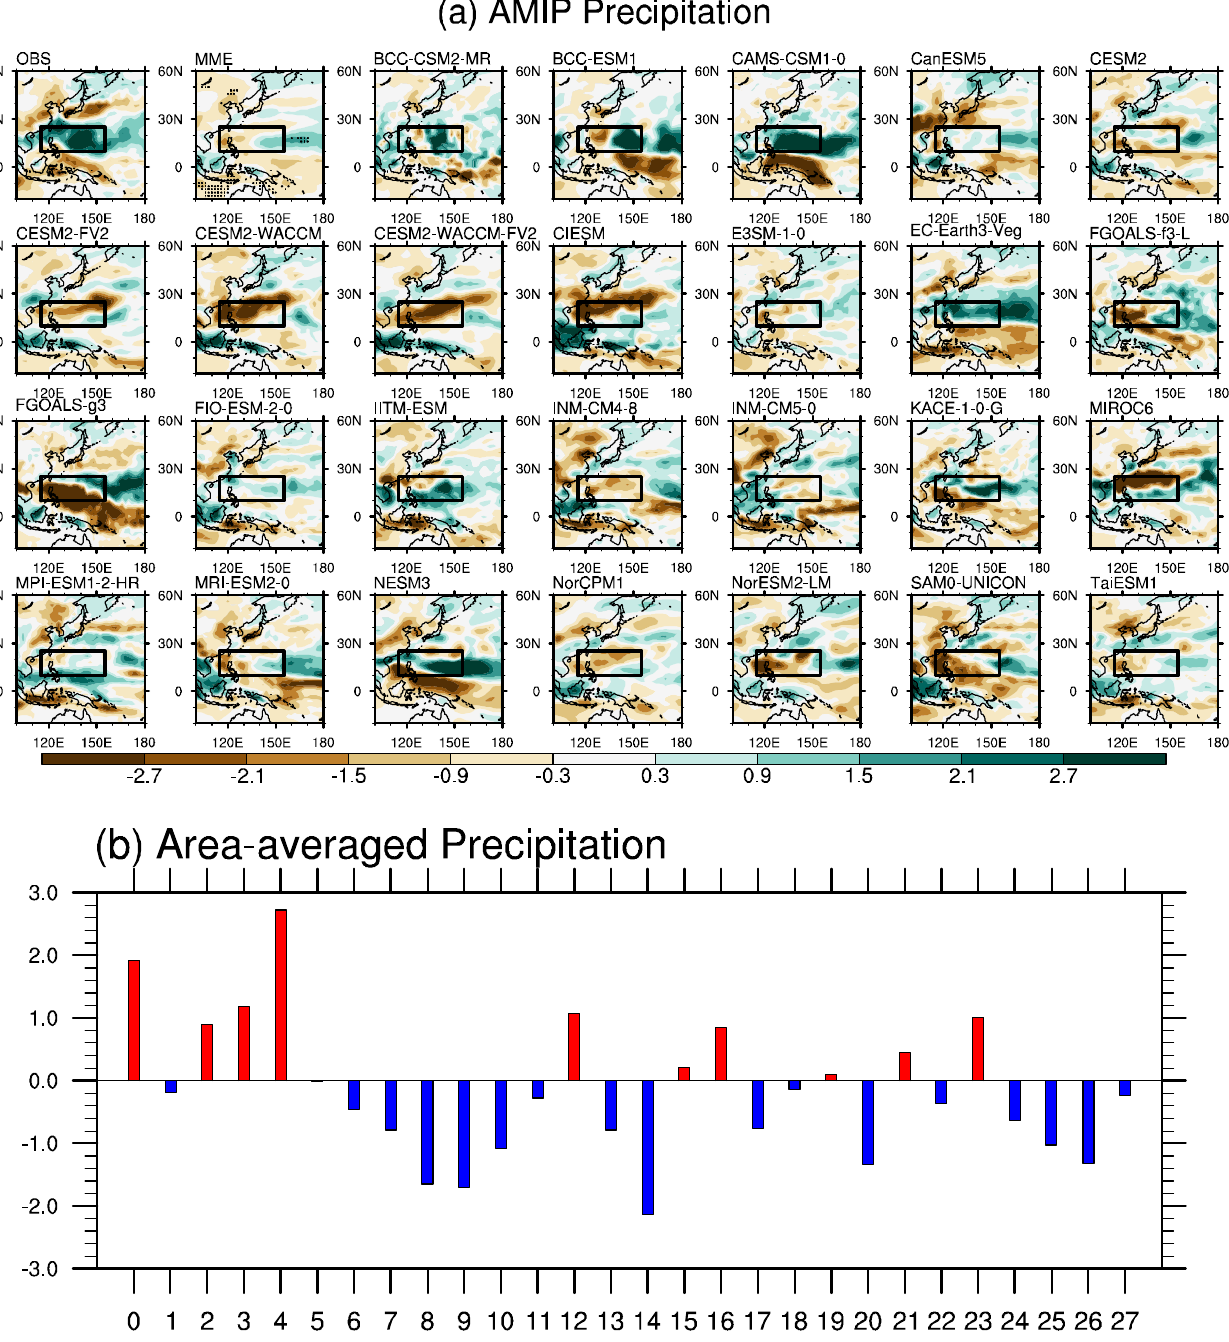
Figure 7. ( a ) Climatological precipitation change in observation, multi-model ensemble (MME) of AMIP simulations, and AMIP simulations from each model (units: mm/d). Black dots in MME denote the regions where 80% of the CMIP6 model results agree with the ensemble mean results. ( b ) The area-averaged precipitation change over the main focus region in this study (10–25 ◦ N, 115–155 ◦ E). The change means the difference between August and